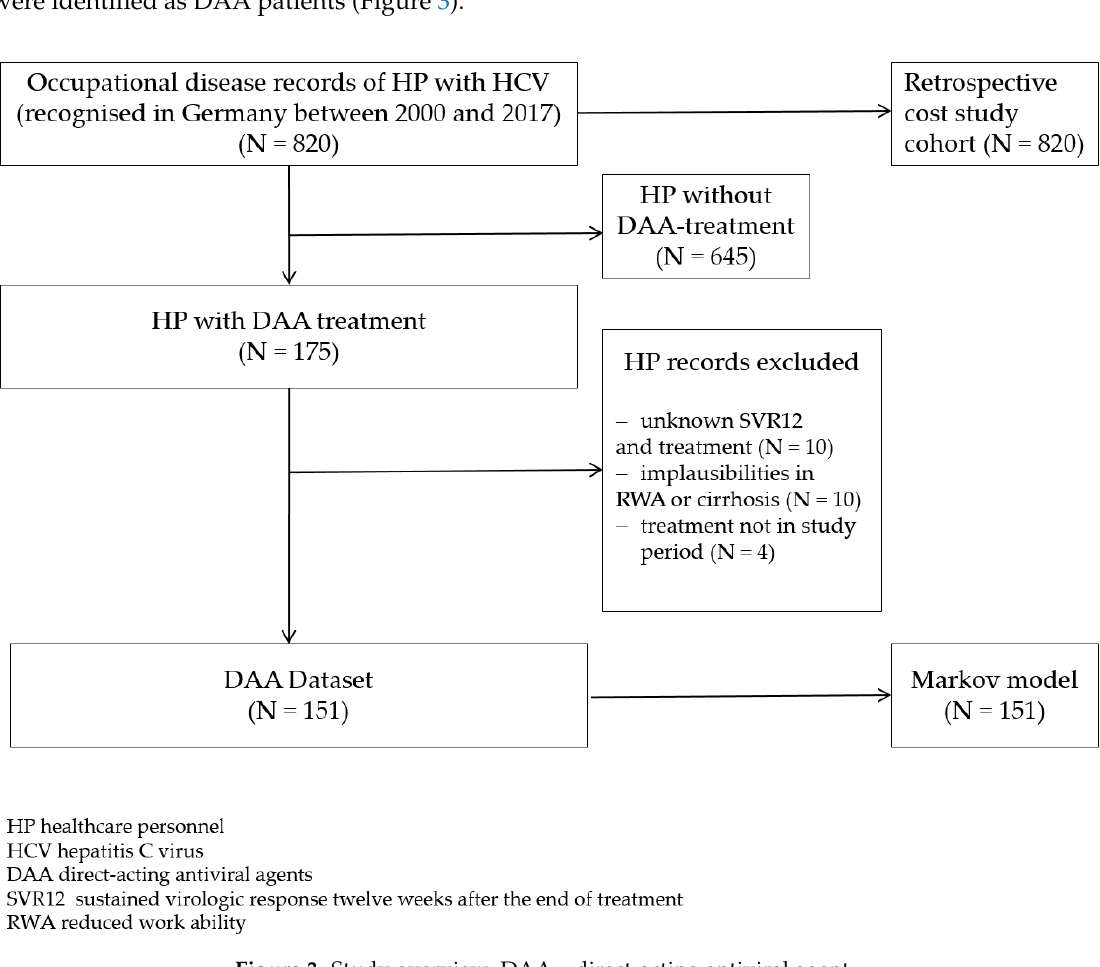
Figure 3. Study overview. DAA—direct-acting antiviral agent.